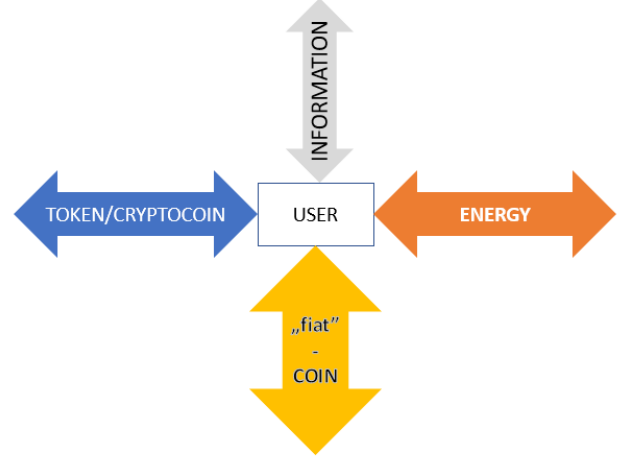
Figure 3. Streams reaching a user in the system.